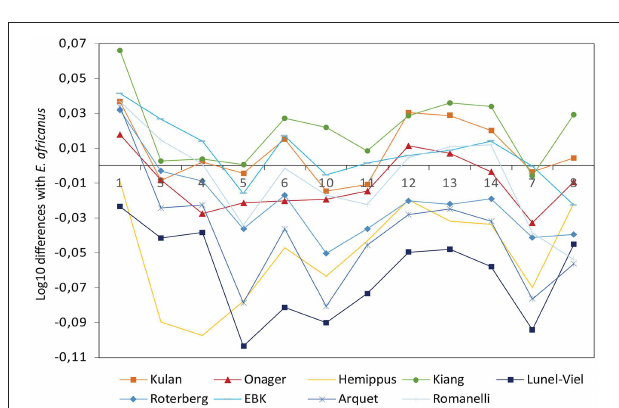
FIGURE 12 | Simpson’s ratio diagram of metacarpals from subspecies of extant Hemiones and Equus hydruntinus . Reference: Equus africanus (Eisenmann, 2019). Measurement system (Eisenmann, 2019): 1-Maximum length, 3-Breadth at the middle of the diaphysis, 4-Depth of the diaphysis at the same level, 5-Proximal articular breadth, 6-Proximal articular depth, 7-Diameter of the facet for capitatum, 8-Diameter of the facet for hamatum, 10-Distal supra-articular breadth, 11-Distal articular breadth, 12-Depth of the sagittal crest, 13-Minimum depth of the medial condyle, 14-Maximum depth of the medial condyle. Data: Hemiones, E. hydruntinus from Roterberg and Romanelli (Eisenmann, 2019); E. hydruntinus minor from Lunel-Viel, E. hydruntinus davidi from Arquet (Boulbes, pers. data); Equus hydruntinus from Emine-Bair-Khosar (van Asperen et al.,